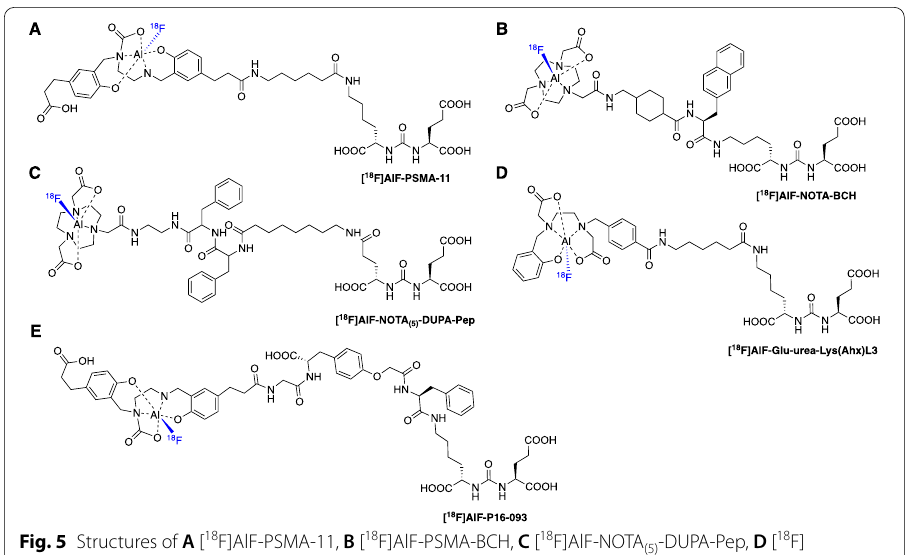
Fig. 5 Structures of A [ 18 F]AlF-PSMA-11, B [ 18 F]AlF-PSMA-BCH, C [ 18 F]AlF-NOTA (5) -DUPA-Pep, D [ 18 F] AlF-Glu-urea-Lys(Ahx)L3 and E [ 18